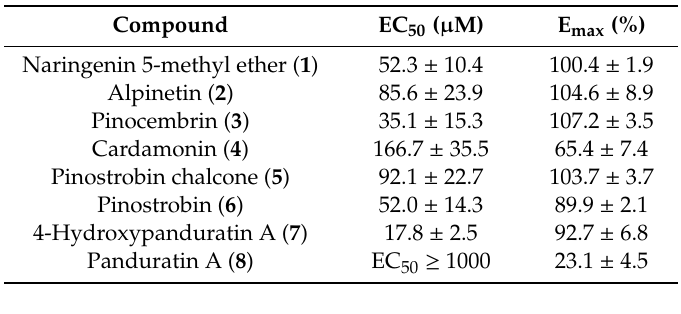
Table 1. Values of half maximal effective dose (EC 50 ) and the maximum effect (E max ) of isolated compounds from BRE.